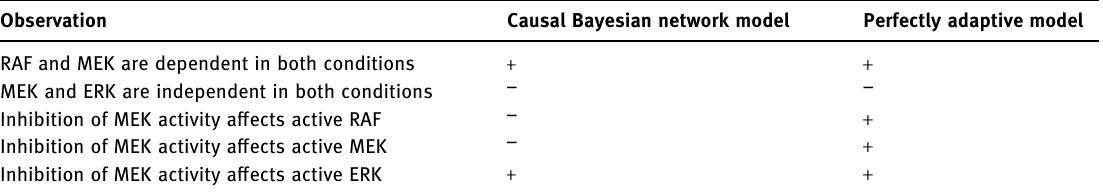
Table 1: For various observations in the data of [ 18 ] , we indicate whether they are predicted by the causal Bayesian network model RAF MEK ERK → → proposed by ref. [ 18 ] and by our perfectly adaptive equilibrium model ( Section 5.2 ) Observation RAF and MEK are dependent in both conditions MEK and ERK are independent in both conditions